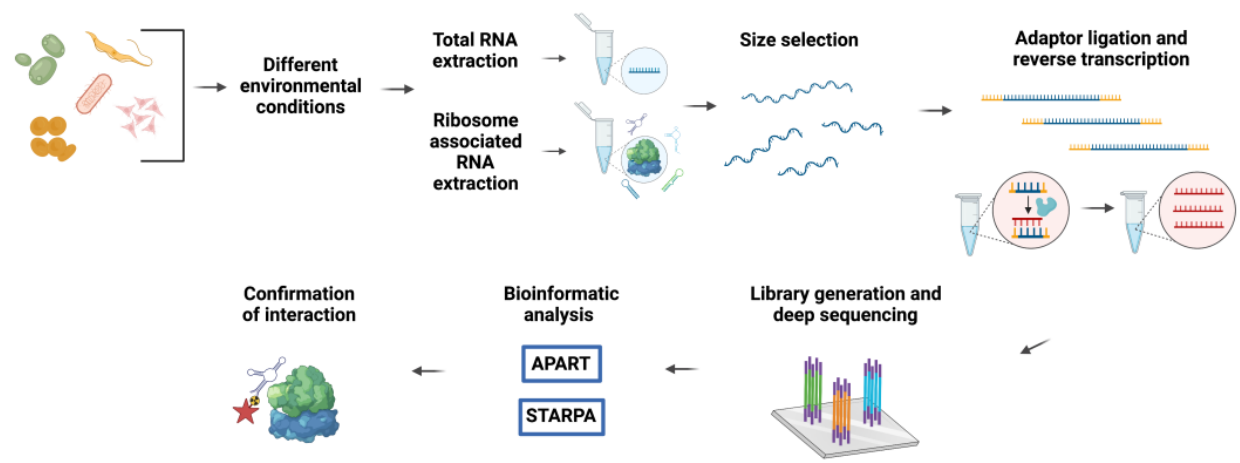
Figure 2. The general workflow adopted for the isolation and identification of